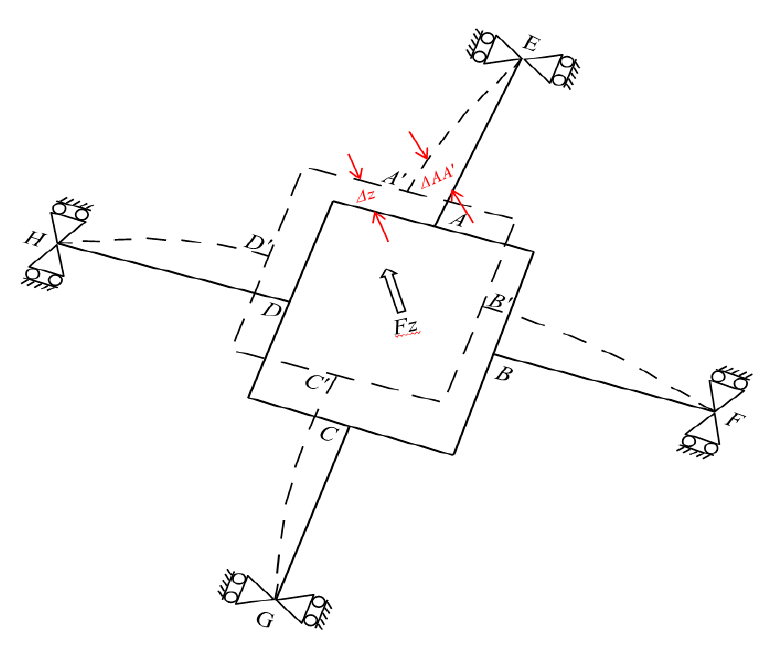
Figure 7. Deformation of the elastic body under force F